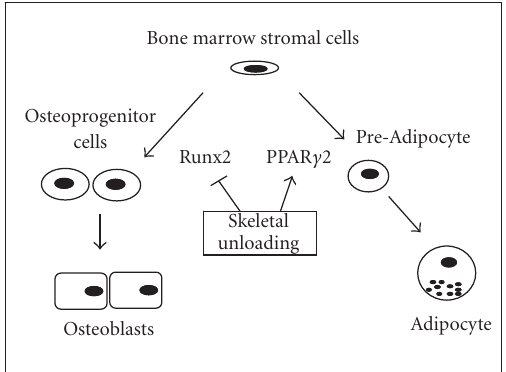
Figure 1: The in vivo di ff erentiation of bone marrow stromal cells towards adipocytes and osteoblasts is governed by the balance be- tween PPAR γ 2 and Runx2 expression. In unloaded bone, decreased Runx2 and increased PPAR γ 2 expression result in decreased os- teoblastogenesis, increased adipogenesis, and bone